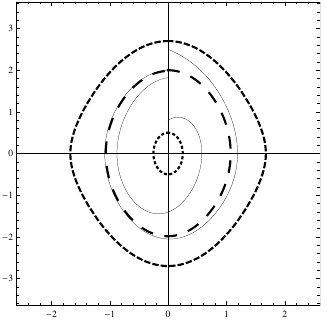
Figure 2. The middle dashed line represents a limit cycle in Example 1, x (0) = 0 , x (cid:48) (0) = 2 . 0. Two solutions are shown tending to the limit cycle, x (0) = 0, x (cid:48) (0) = 0 . 8, x (0) = 0, x (cid:48) (0) = 2 . 5. The period annulus of the conservative equation which transforms to the Poincar´e–Bendixson region for the Li´enard type equation is marked by two dashed closed inner and outer